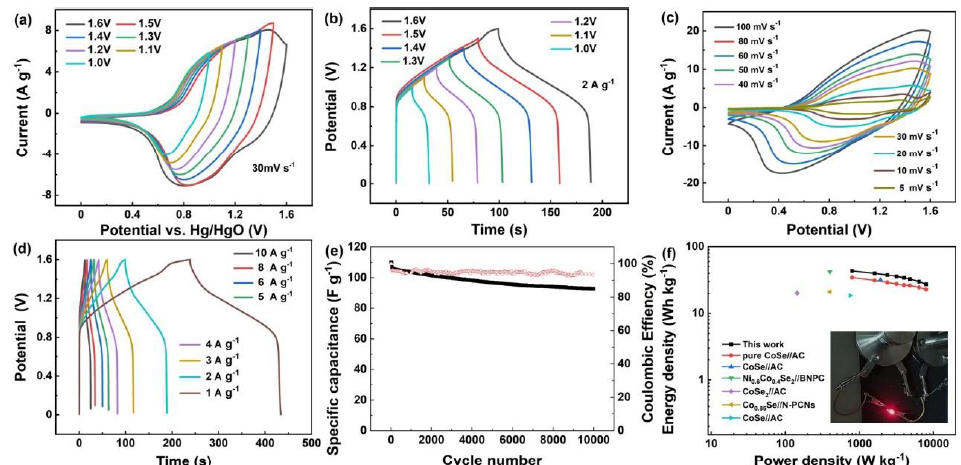
Figure 4. ( a , b ) CV and GCD curves of CoSe/Co 3 O 4 -CNTs/NF//AC ASC at different potential windows, ( c , d ) CV and GCD curves of CoSe/Co 3 O 4 -CNTs/NF//AC ASC at different scan rates and current densities, ( e ) cycling performance of CoSe/Co 3 O 4 -CNTs/NF//AC, ( f ) Ragone plot of CoSe/Co 3 O 4 -CNTs/NF//AC ASC. The inset in ( f ) is photographic images of the two series of connected CoSe/Co 3 O 4 -CNTs/NF//AC ASCs with a red LED.